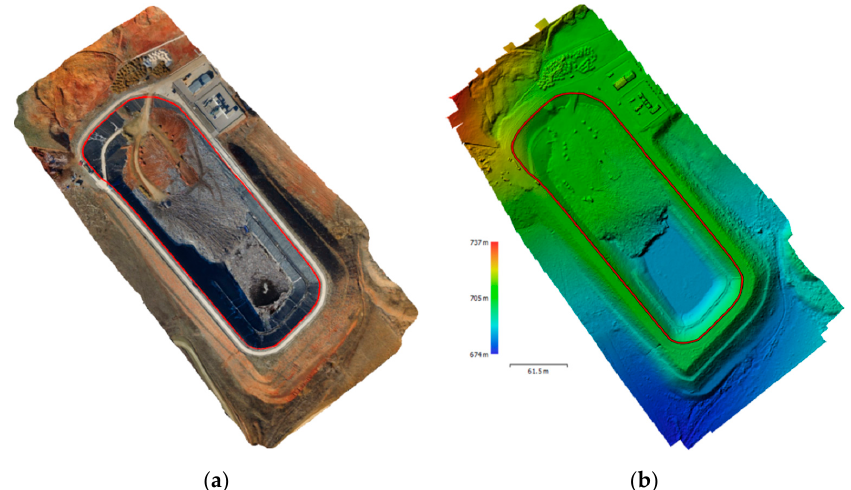
ISPRS Int. J. Geo-Inf. 2019 , 8 FOR PEER REVIEW Figure 4. ( a ) Outer boundary on the tiled model; ( b ) outer boundary on the corresponding DEM.